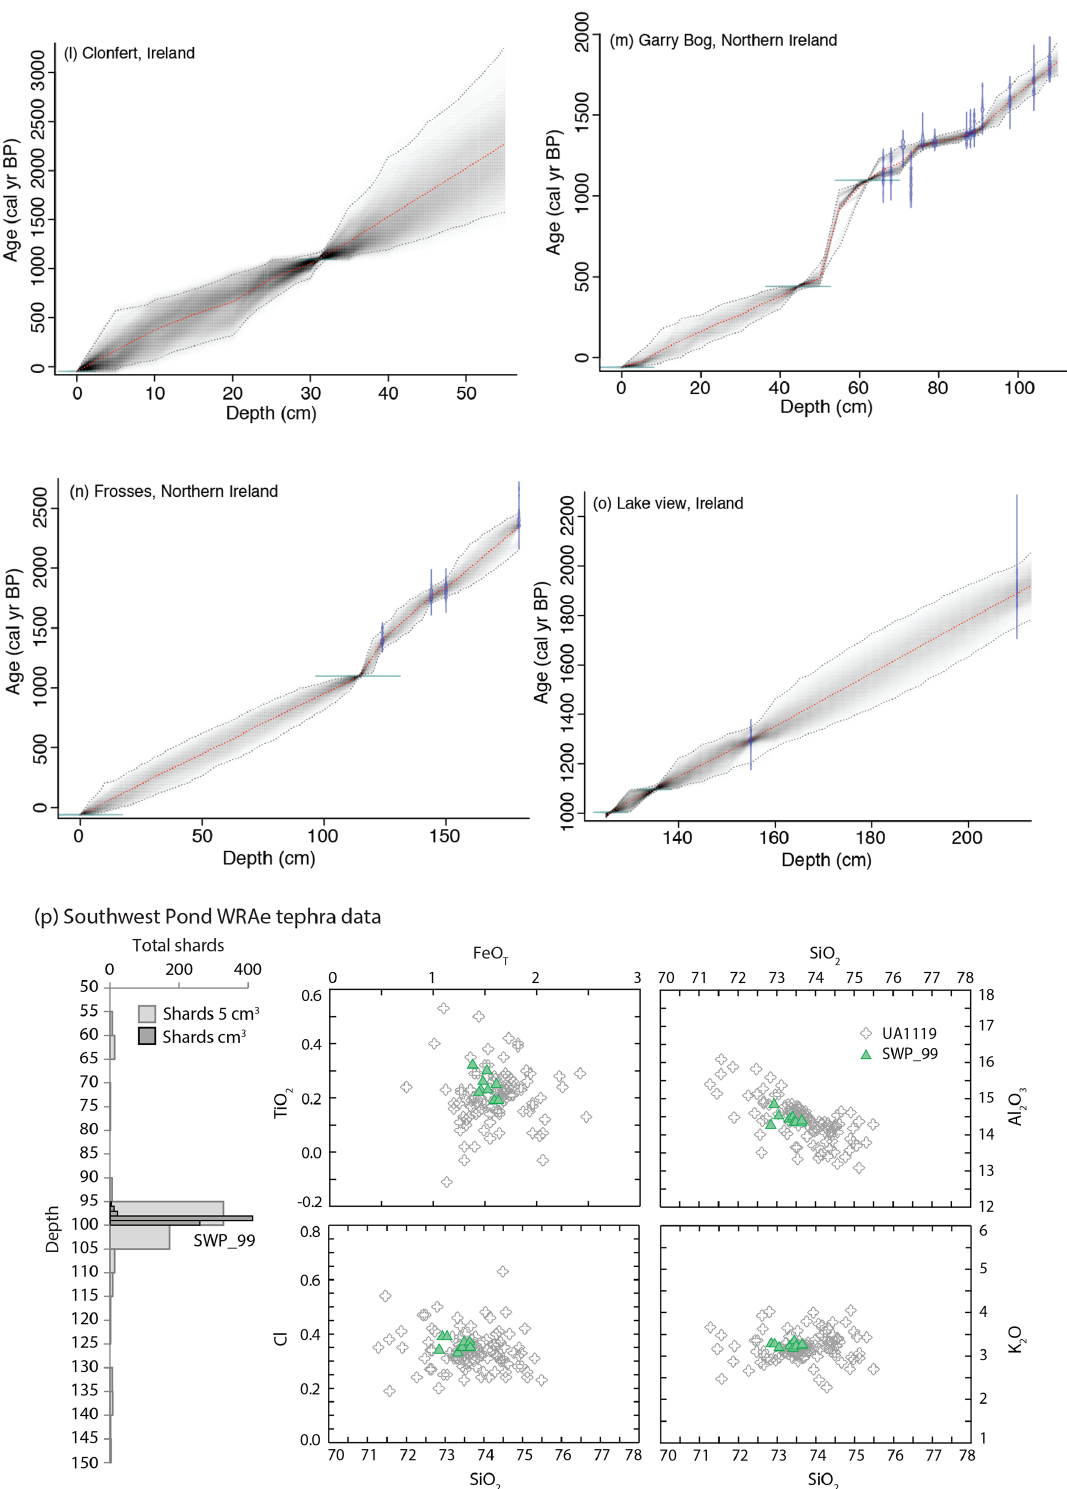
Figure D1. (a–o) Core chronologies (Fig. S1a–o) were developed using Bayesian analysis within the R package “BACON” (Blaauw and Christen, 2011) based on 14 C dates (calibrated using NH IntCal20 calibration curve; Reimer et al., 2020) and tephrochronologies. (p) Shard counts and major–minor element glass compositions for the WRAe in Southwest Pond bog. Comparative glass electron probe microanalysis data (UA1119) are taken from Jensen et al.